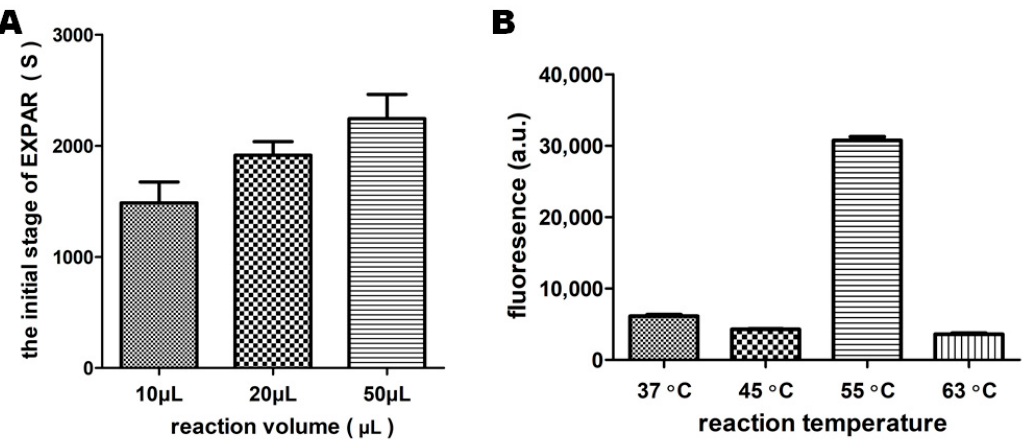
Figure 2. Effect of different reaction volumes and temperatures on EXPAR. ( A ) With the increase in reaction volume, the time of the EXPAR initial stage increased gradually; ( B ) Under different reaction temperatures, experimental results show different fluorescence values.